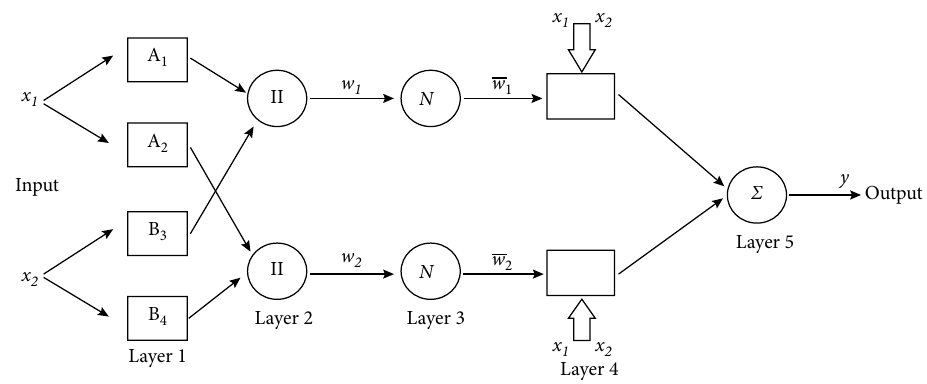
Figure 1: The diagram of adaptive network-based fuzzy inference